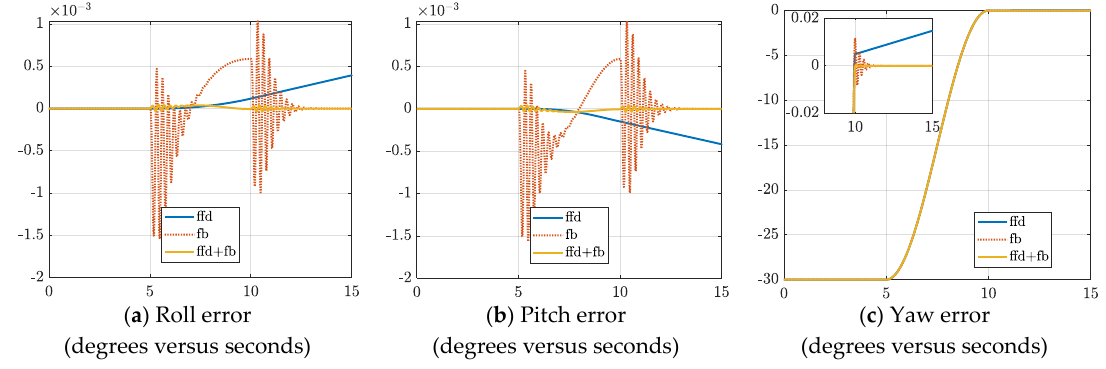
Figure 7. Euler Angle error for the three controller configurations.